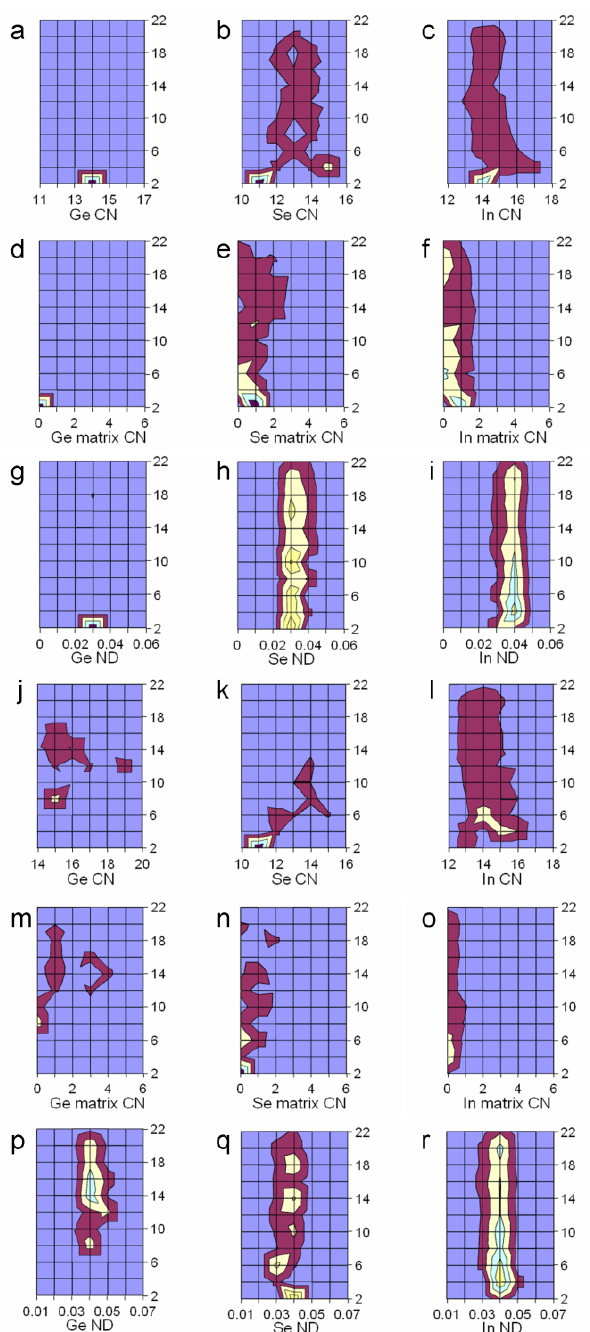
Figure 3. Surface plots of the radial distribution of coordination and number density for Ge-, Se- and In-centered clusters (the radial direction is measured from the origin of the RMC simulation box and is the vertical axis in units of Å). Panels ( a ) to ( i ) refer to the GeSe 4 In 10 system while ( j ) to ( r ) refer to GeSe 4 In 15 . Horizontal axis notation is as follows: CN: average coordination number, matrix CN: average coordination of the cluster center by Ge (“matrix” refers to the first atomic species in the chemical formula, i.e. , Ge, by convention), ND: number density (atoms/Å 3 ) and D: density (g/mL). Increasing iso-surface values are shown as a progression of blue, dark red, pale white, yellow, cyan and dark brown